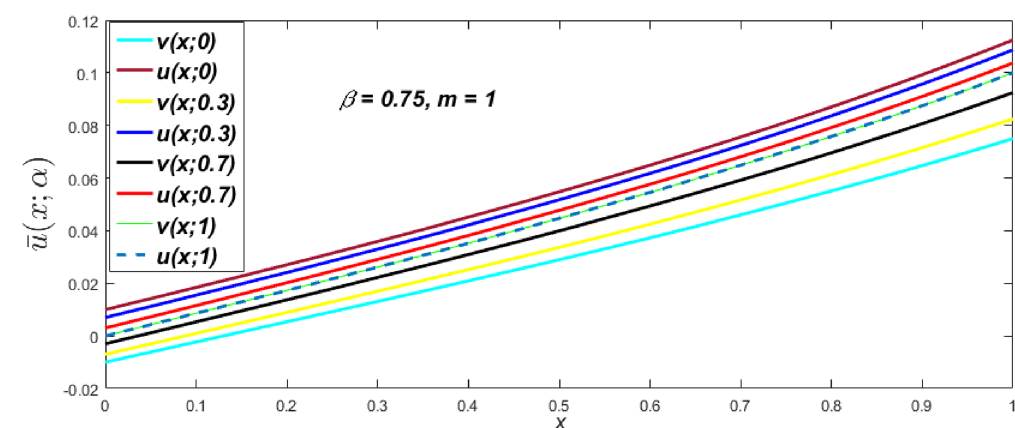
Figure 11. Fuzzy velocity profiles for different values of α -cut.